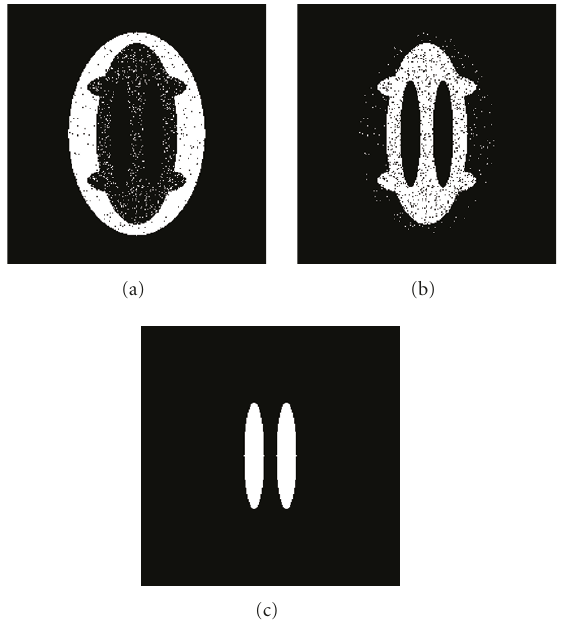
Figure 9: Classification results of AIS-CSA of simulated image with 5dB noise: (a) GM; (b) WM; and (c) CSF.